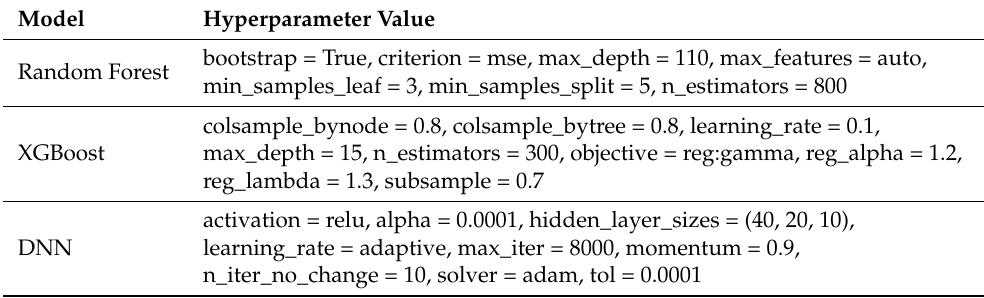
Table 2. Optimized hyperparameters for different ML-based regression models trained, validated and tested on the OB-set .